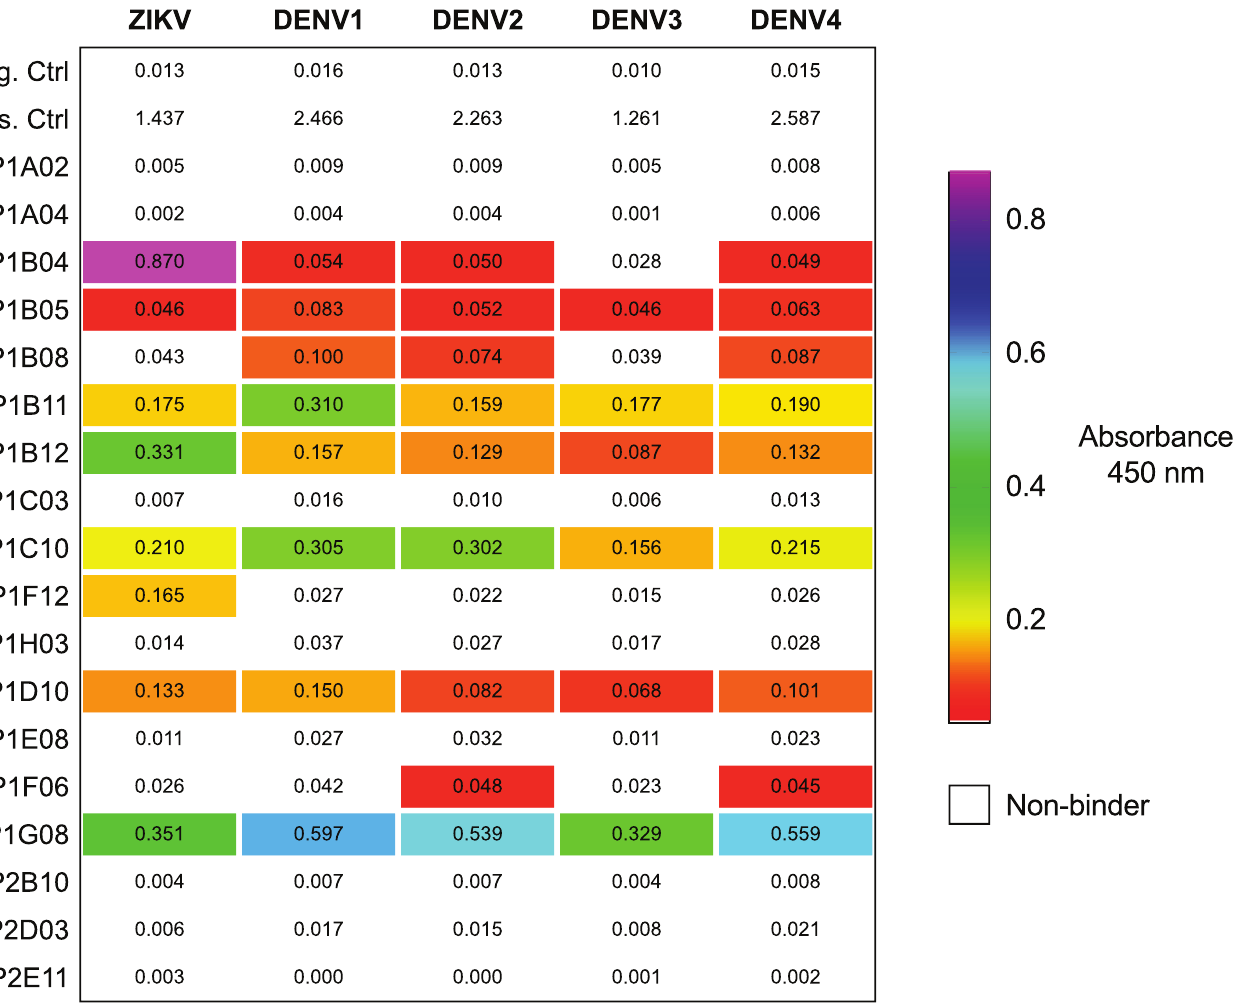
Fig 1. P1F12 mAb binds to whole ZIKV, but not DENV. The extent of mAb binding to ZIKV and the four DENV serotypes was quantified using a virus capture ELISA. The ability of purifiedmAbs (1 μ g / ml) to bind to captured DENV and ZIKV was assessed. Absorbance (Abs 450) values higher than three times the negativecontrol wells were considered